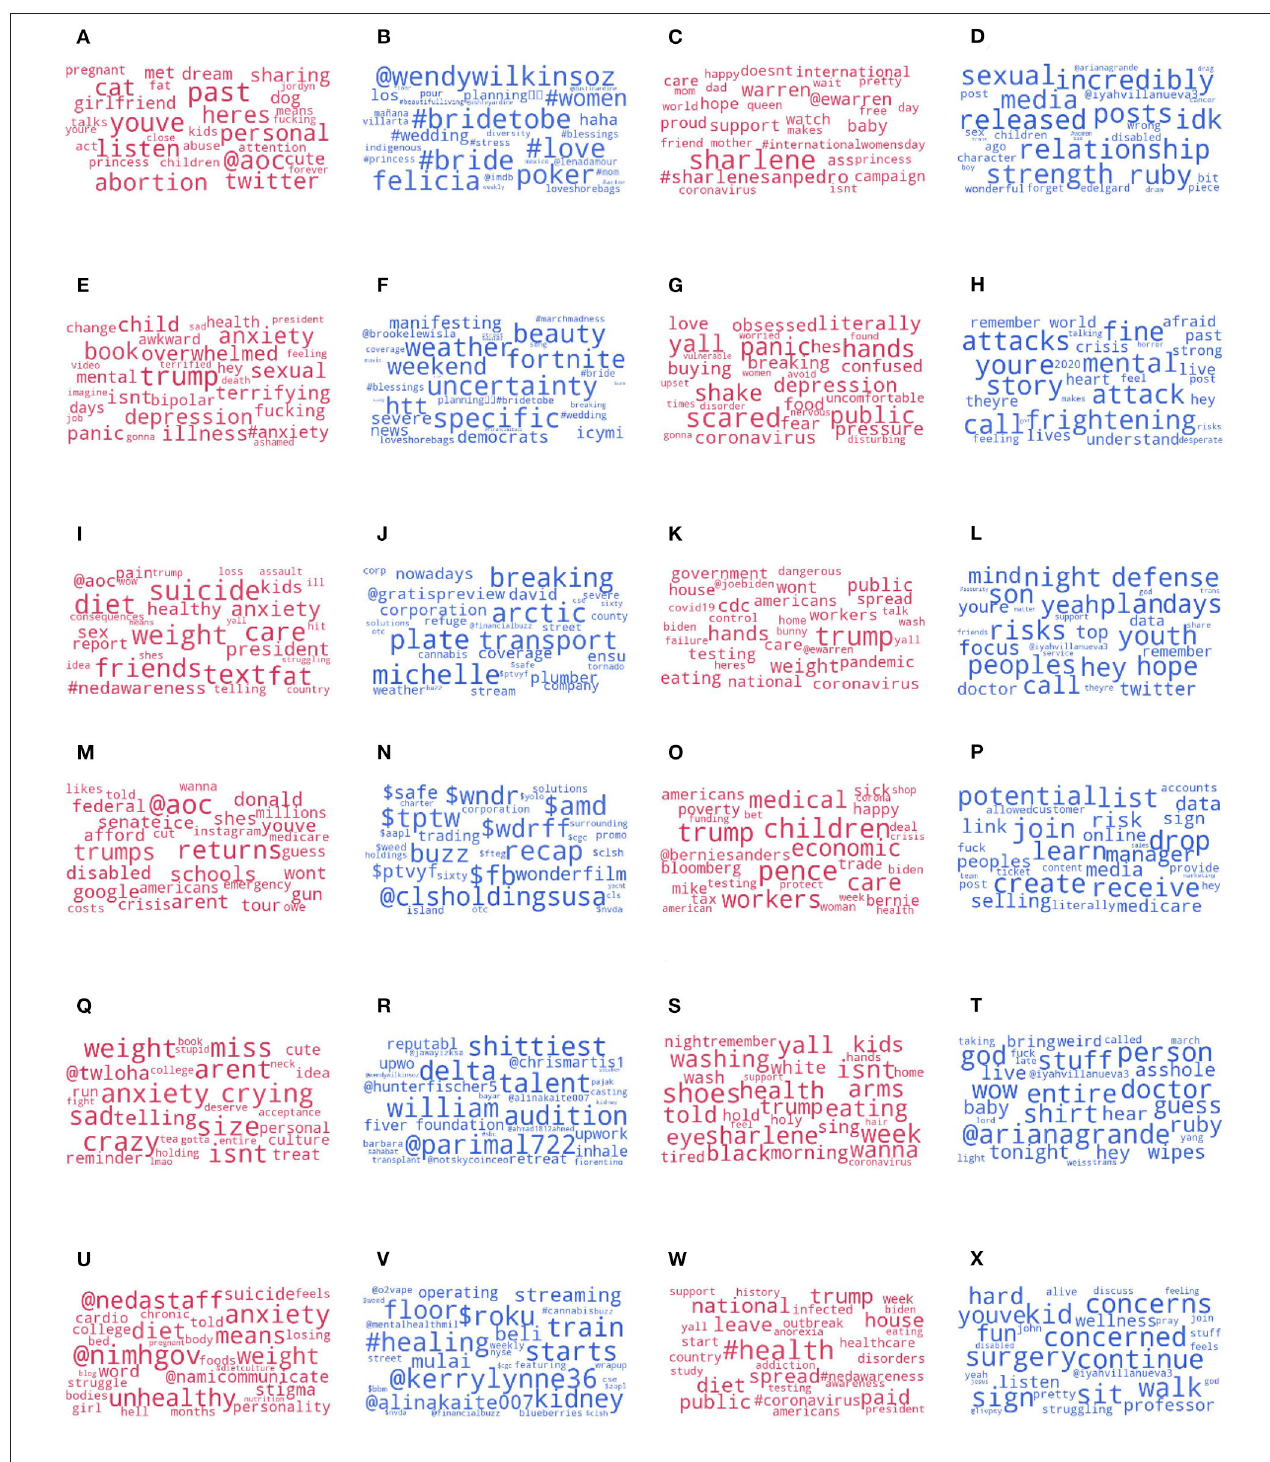
FIGURE 7 | Top 30 words in categories, by gender and year. (A) Female: Female 2019, (B) Female: Male 2019, (C) Female: Female 2020, (D) Female: Male 2020, (E) Anxiety: Female 2019, (F) Anxiety: Male 2019, (G) Anxiety: Female 2020, (H) Anxiety: Male 2020, (I) Risk: Female 2019, (J) Risk: Male 2019, (K) Risk: Female 2020, (L) Risk: Male 2020, (M) Money: Female 2019, (N) Money: Male 2019, (O) Money: Female 2020, (P) Money: Male 2020, (Q) Body: Female 2019, (R) Body: Male 2019, (S) Body: Female 2020, (T) Body: Male 2020, (U) Health: Female 2019, (V) Health: Male 2019, (W) Health: Female 2020, and (X) Health: Male 2020.